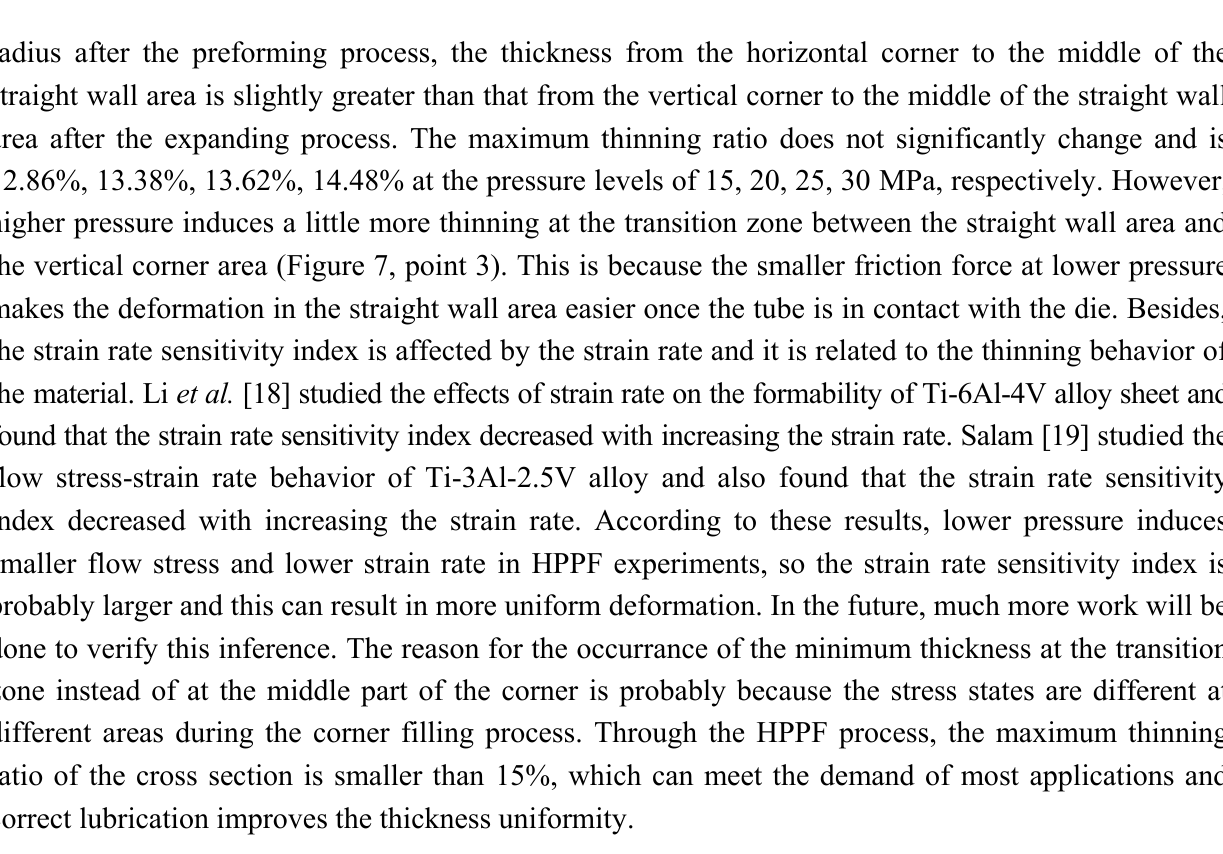
Figure 7. Thickness distribution at 850 °C and at different pressure